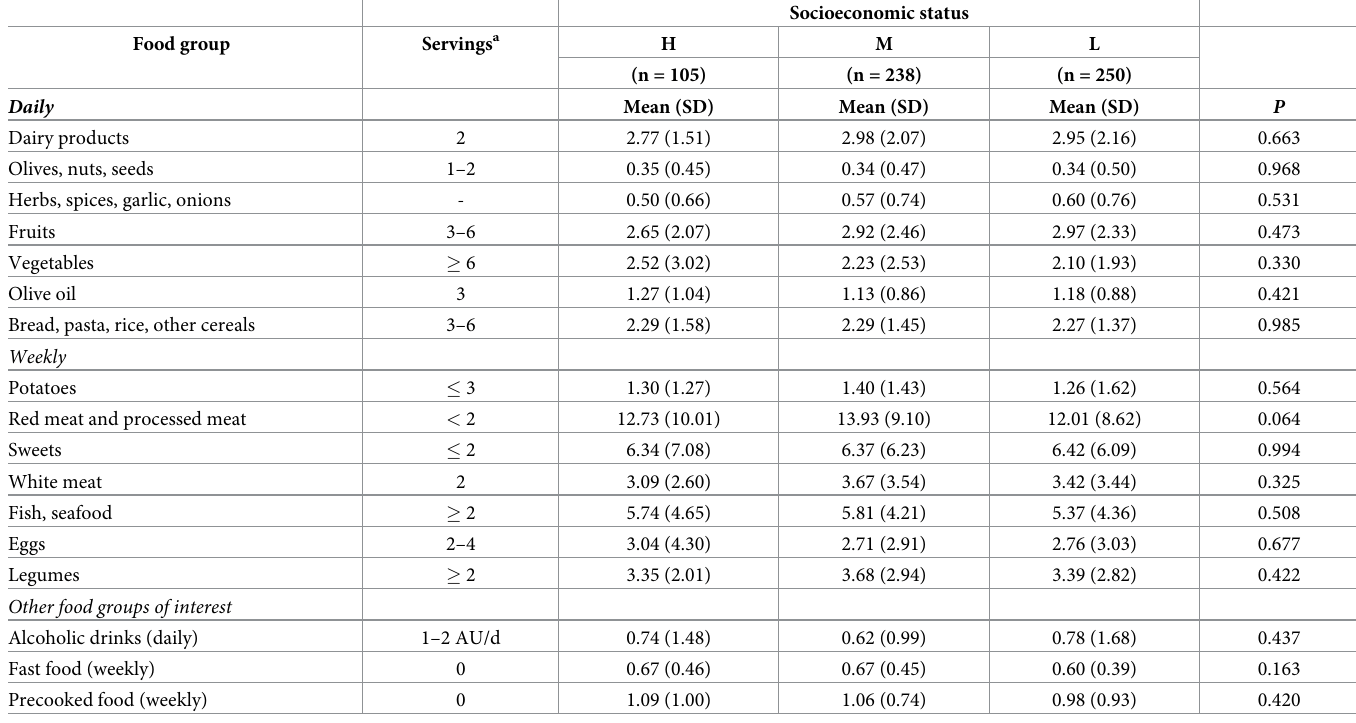
Table 3. Mean differences in food group consumption by family’s socioeconomic status ( n =